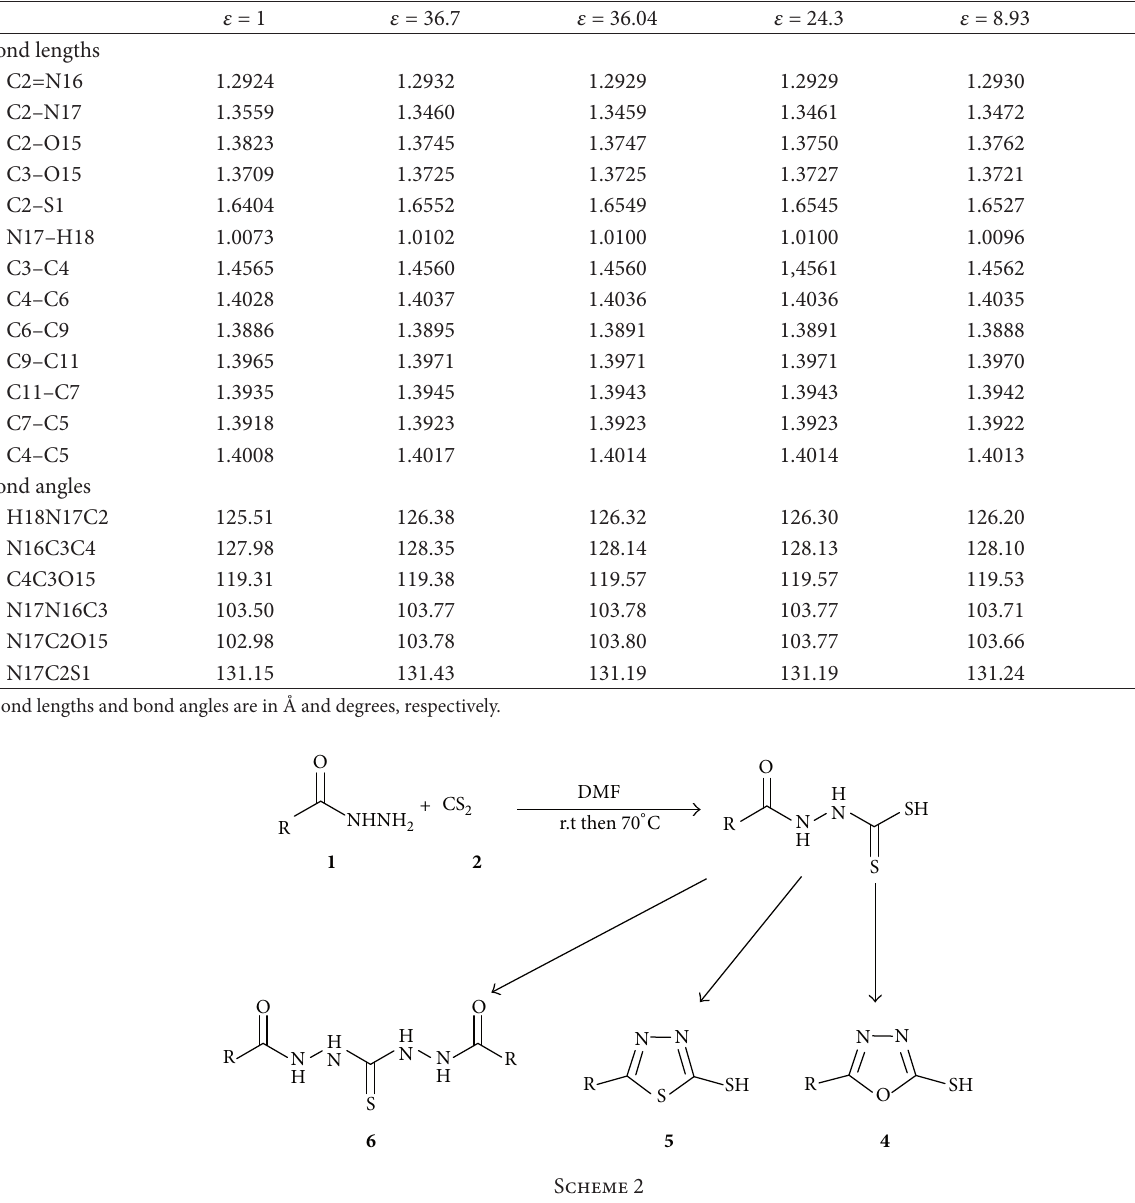
T 5: e geometrical parameters of the tautomer I calculated at the B3LYP level with